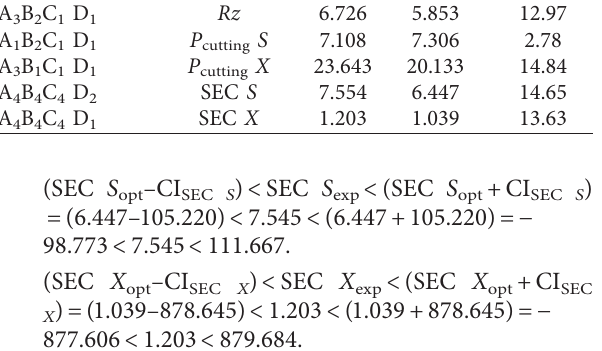
Table 8: Confirmation test results for predicted and experimental values. Optimum